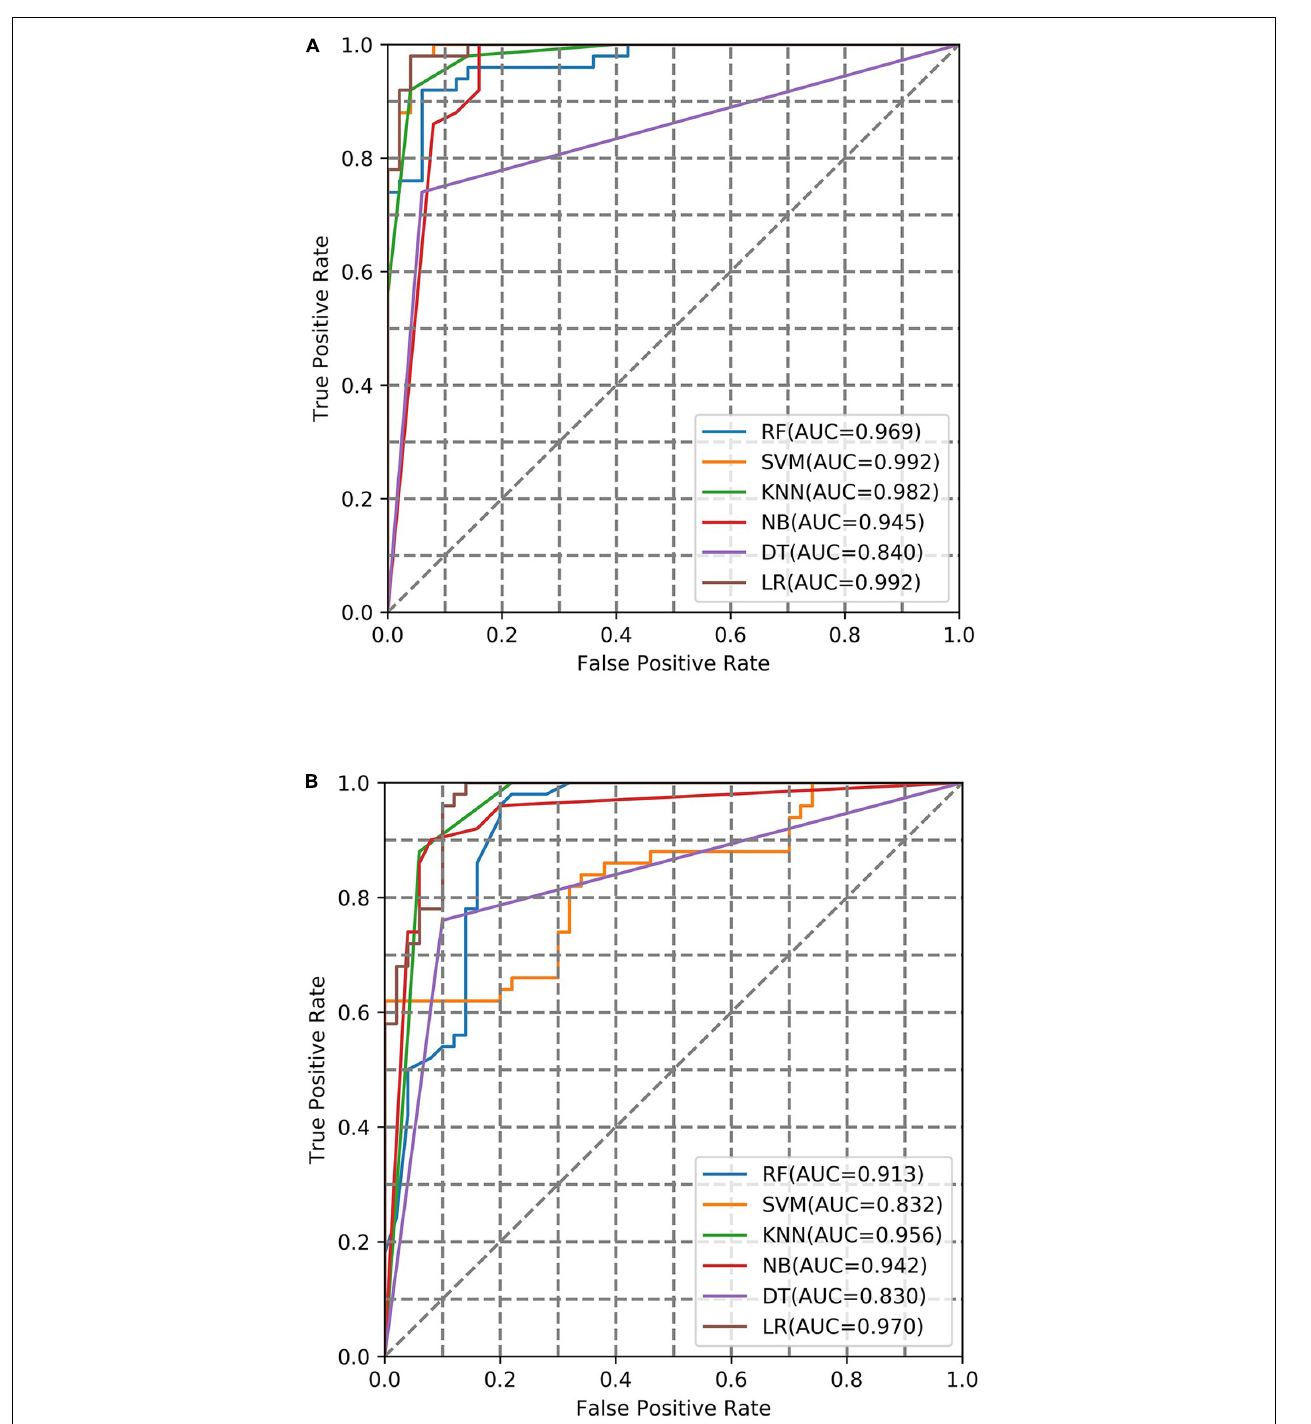
FIGURE 2 | AUC curve of fivefold cross-validation with negative samples from inactive compounds in the case of different ML models. (A,B) are the AUC curve in the 1024-bit and 2048-bit length fingerprints, respectively.